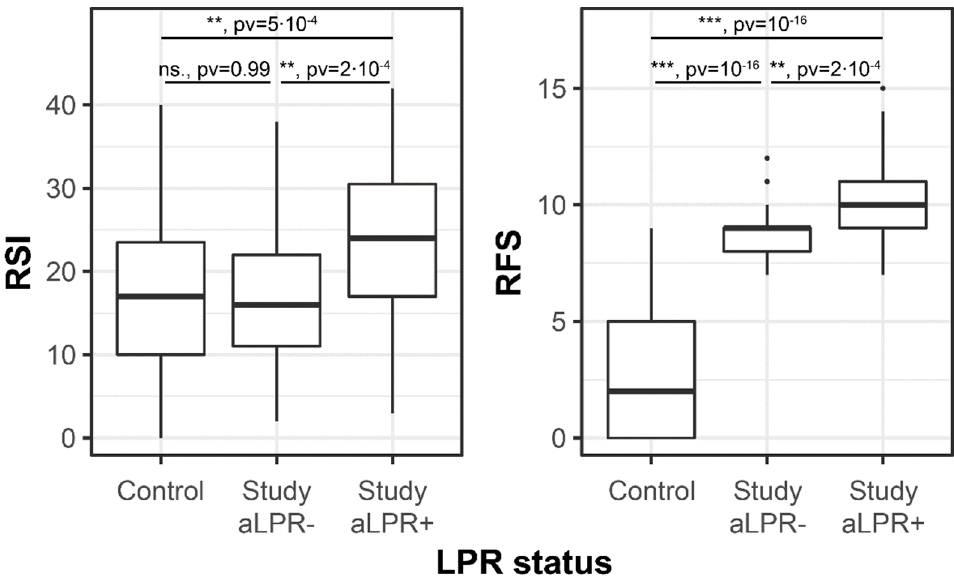
Figure 3. Comparison of PL-RSI and PL-RFS between those in the study group who were identified with acid LPR (aLPR+), those who were acid LPR negative (aLPR-), and the healthy controls (Con- trol). Significance of Student’s t -test was: ** p < 0.01, *** p < 10 − 6 .